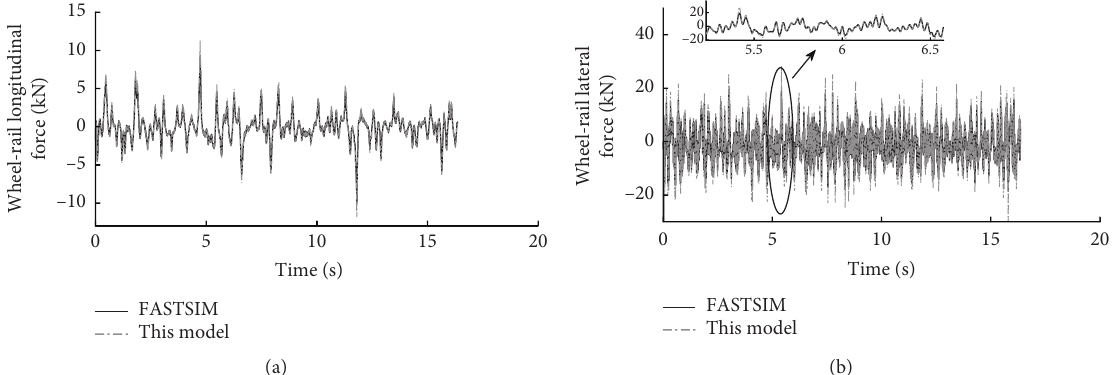
Figure 5: Comparison between FastSim and this dynamic model. (a) Wheel-rail longitudinal force; (b) wheel-rail lateral